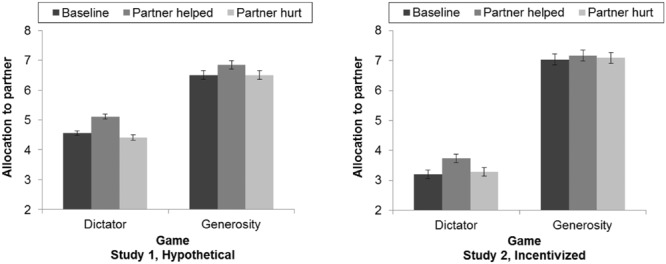
Mean allocations to partner across all games. Error bars represent one standard error. N = 304 (Study 1), 256 (Study 2).